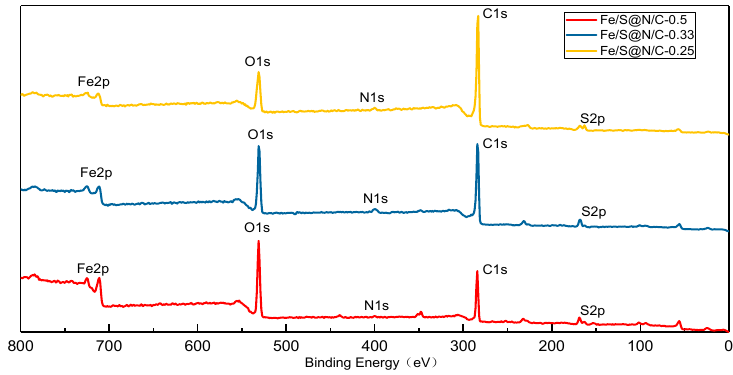
Figure 7. Survey XPS spectrum of Fe / S@N / C-x. Figure 7. survey XPS spectrum of Fe/S@N/C-x.